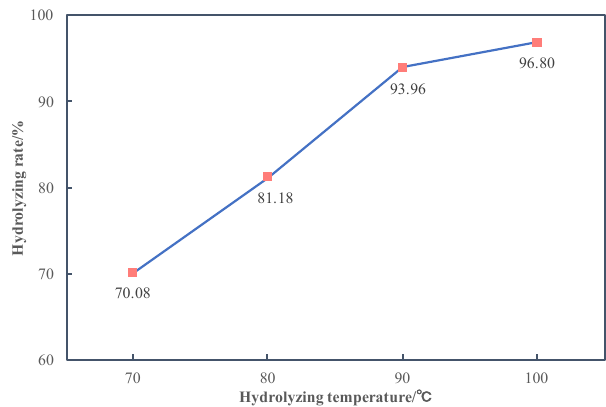
Figure 8. Effect of temperature on hydrolyzing rate of titanium.